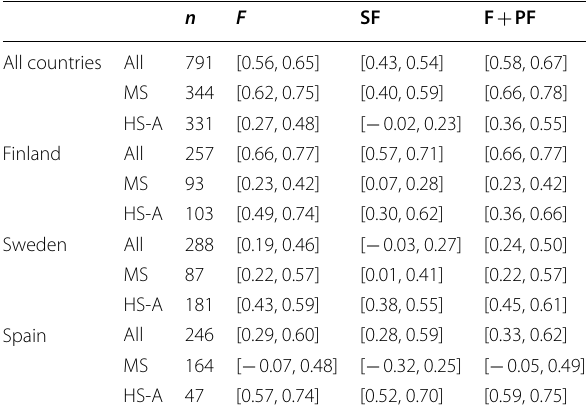
Table 6 Confidence intervals (95%) of Pearson